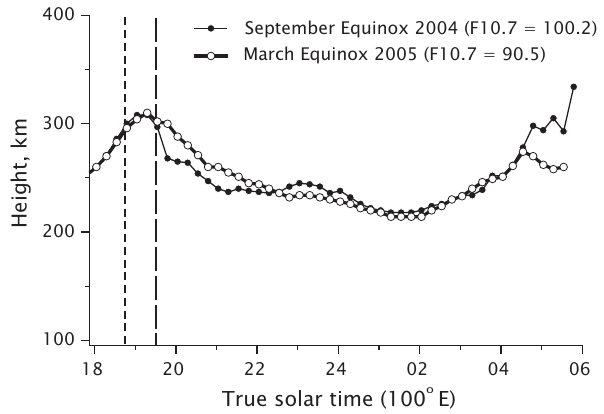
Fig. 3. Equatorial height variations over Chumphon for the same period as that in Fig. 2.